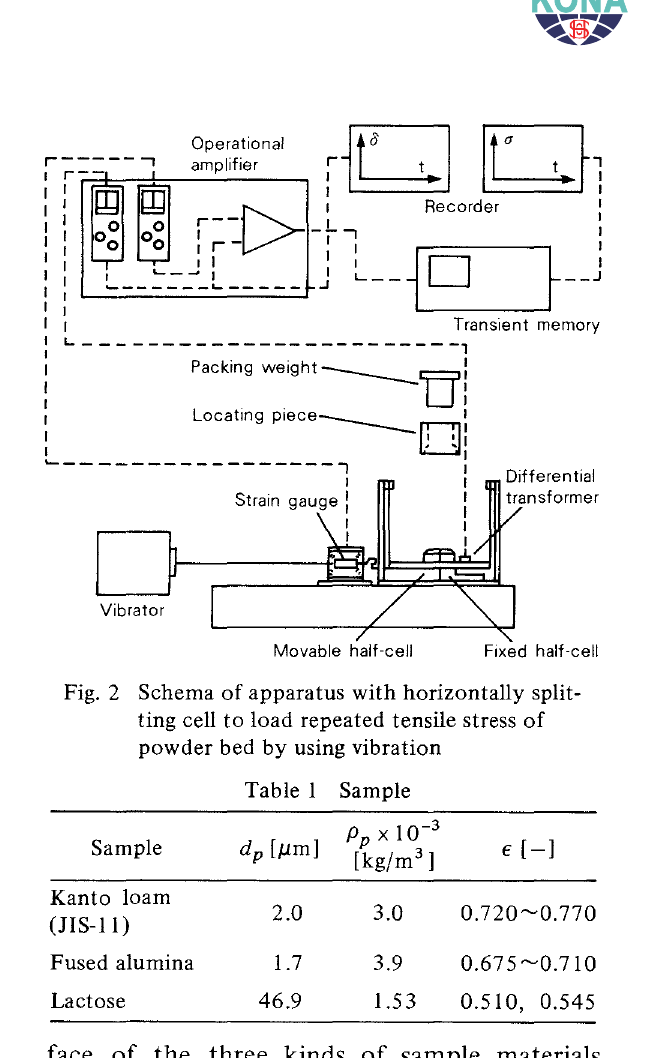
Fig. 2 Schema of apparatus with horizontally split ting cell to load repeated tensile stress of powder bed by using